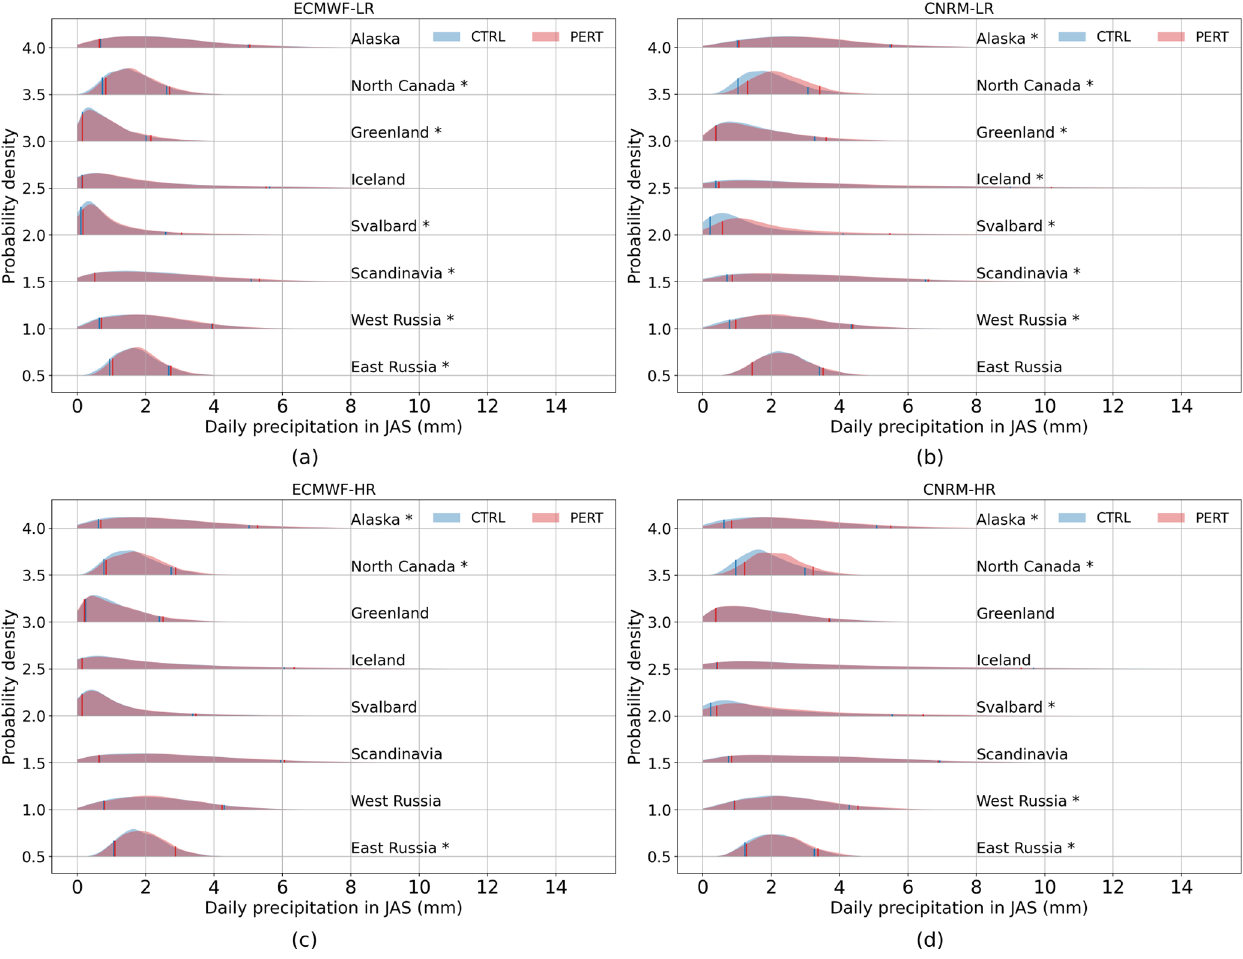
Figure 10. PDF of the daily precipitation in summer (JAS) for ECMWF-LR (a) , CNRM-LR (b) , ECMWF-HR (c) and CNRM-HR (d) . PDF of the CTRL is the blue distribution, and PDF of the PERT is the red distribution. The left blue (red) line and the right blue (red) line correspond to the 10th percentile and 90th percentile of the CTRL (PERT), respectively. A star next to the name of the region shows if the distribution change is statistically significant according to a 5% level Kolmogorov–Smirnov test. An offset on the y axis of 0.1 is taken into account for each